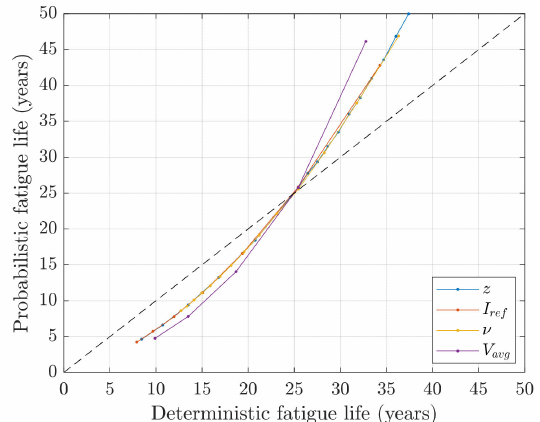
Figure 4. Fatigue life from probabilistic assessment for β = 3.3 as a function of the fatigue life from the deterministic assessment for variations of input parameters: z : design parameter, I ref : reference turbulence intensity, ν : annual number of load cycles, and V avg : 10-min mean wind speed at hub height.